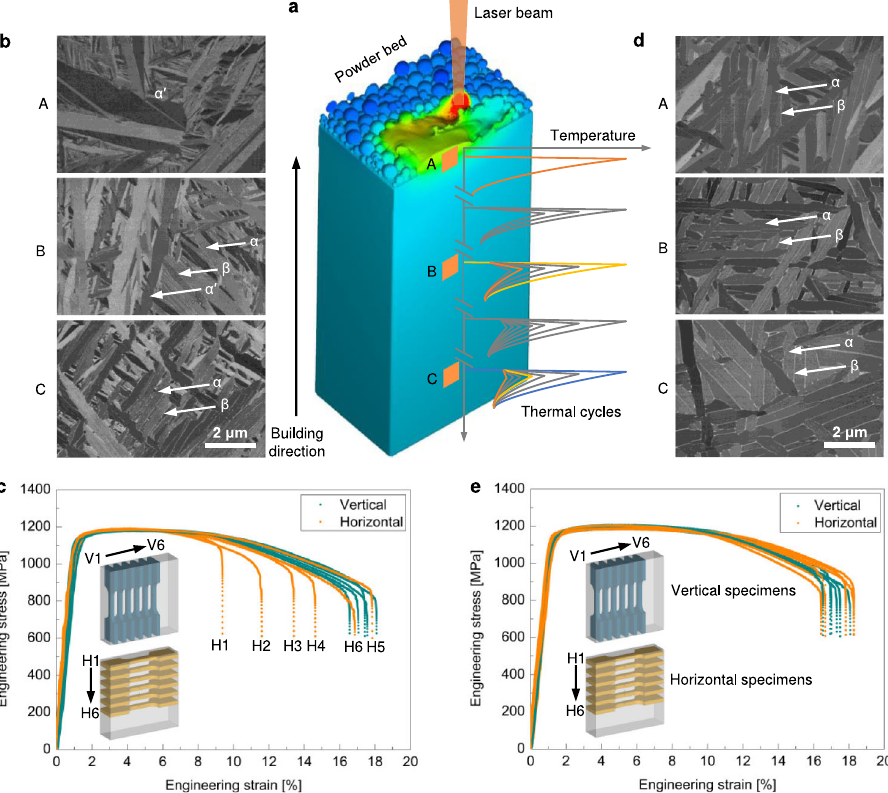
Fig.1|ComparisonofmicrostructuresandtensilepropertiesofTi − 6Al − 4Vand a well-de fi ned lamellar ( α + β ) microstructure. c Tensile engineering stress-strain curvesofTi − 6Al − 4Valongtheverticalandhorizontaldirections.Inset,schematicof preparationofverticalandhorizontaltensilespecimensfromtheas-builtparts.The horizontal tensile specimens are marked from H1 to H6 along the building direc- tion. d SEM-BSE micrographs showing homogeneous lamellar ( α + β ) micro- structure in the newly developed 25Ti − 0.25O alloy (lower magni fi cations in Supplementary Fig. 1). The well-de fi ned lamellar ( α + β ) microstructure can be observed from the top surface to the bottom region. e , Tensile engineering stress- straincurvesof25Ti − 0.25Oalloyalongtheverticalandhorizontaldirections.Inset, the preparation of the tensile specimens is the same as that of Ti − 6Al −